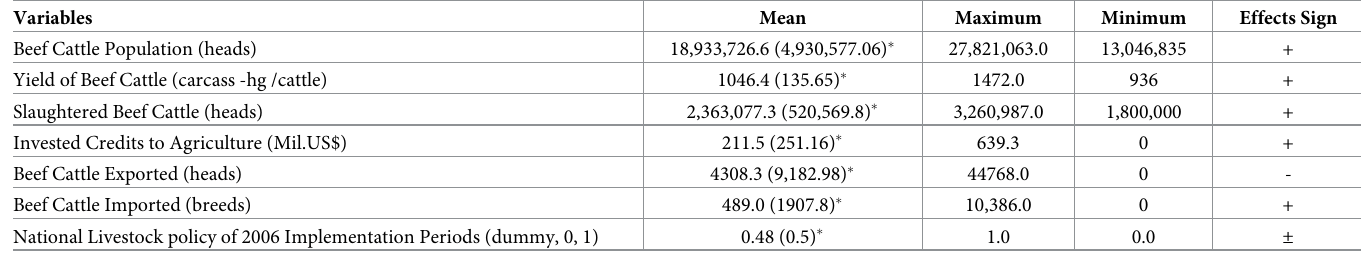
Table 1. Descriptive statistics and expected sign effects of the independent variables on beef meat production quantity from 1990 to